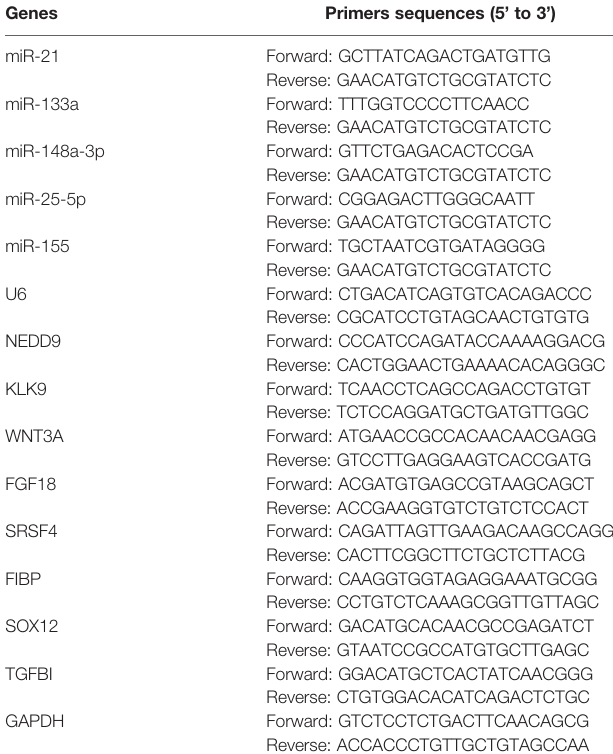
TABLE 2 | The sequence of primers used for real-time qPCR analysis.